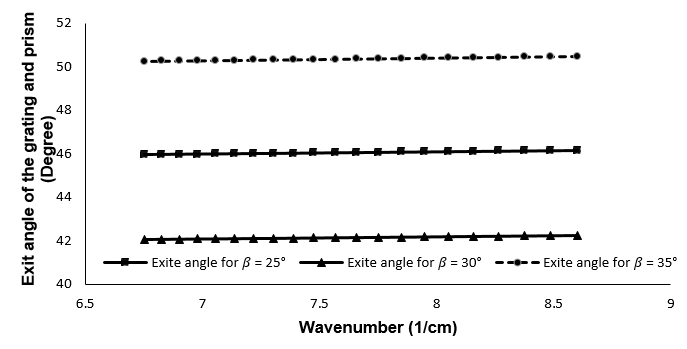
Figure 10. Exit angle of the grating for different β .